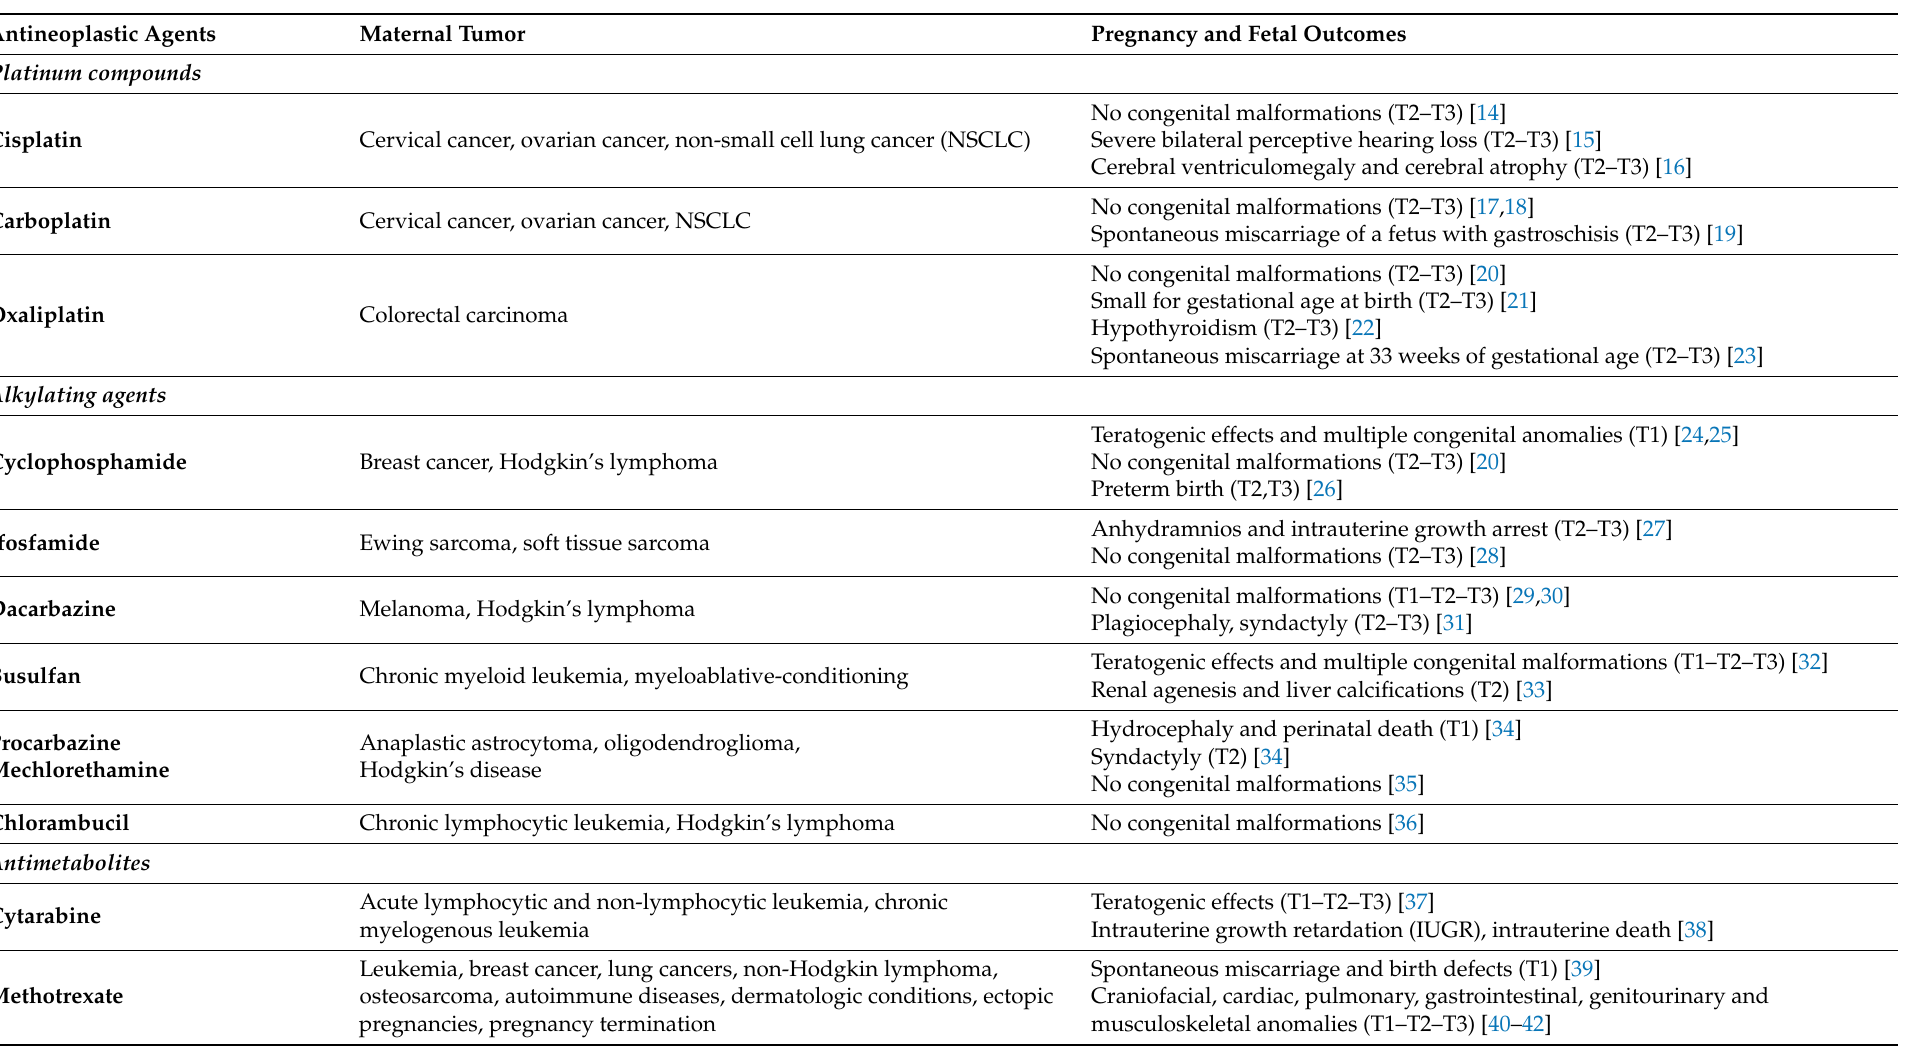
Table 1. Pregnancy and fetal outcomes after human intrauterine exposure to antineoplastic